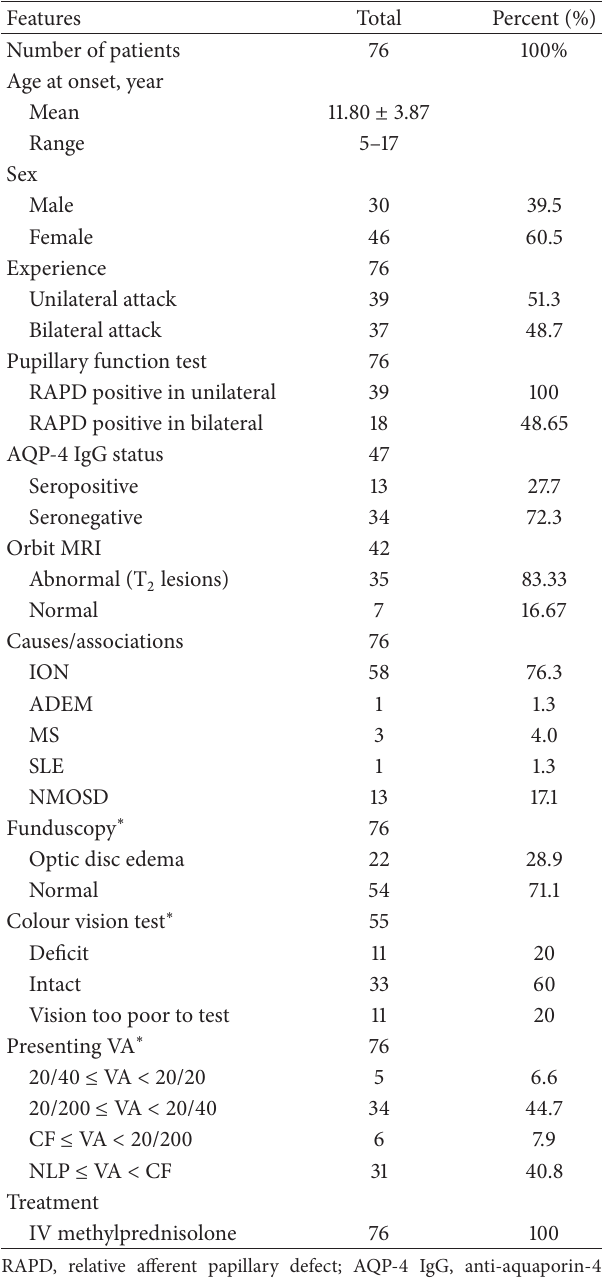
Table 1: Demographic and clinical characteristics of Chinese children with optic